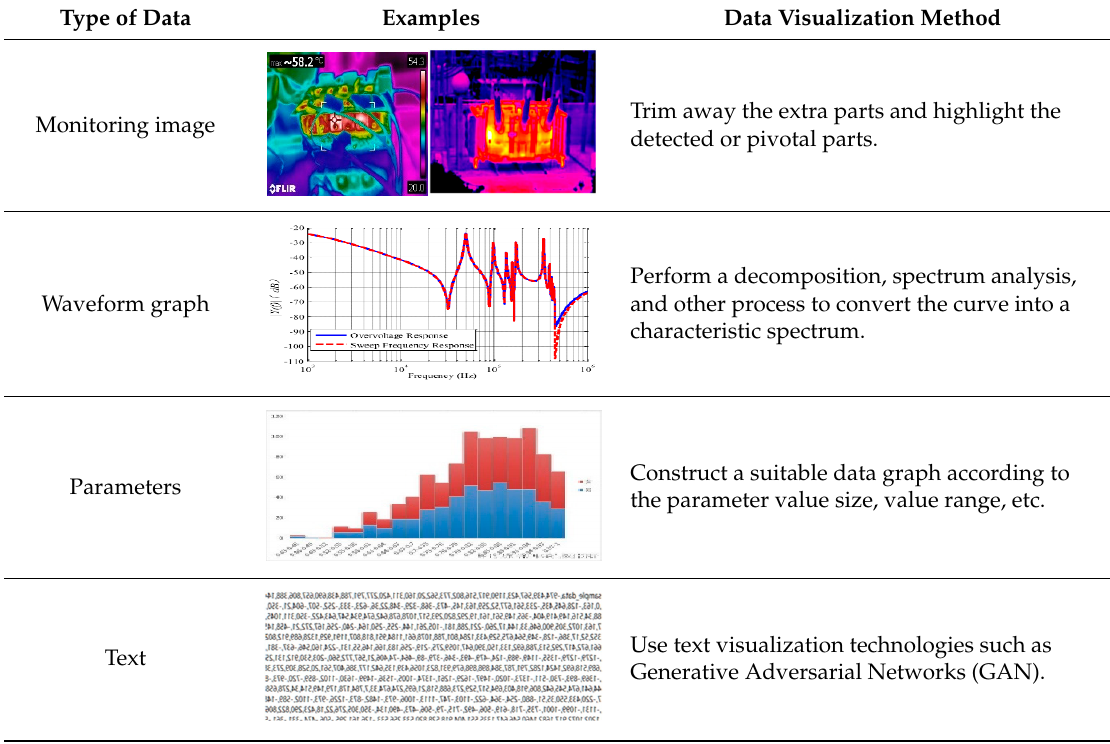
Table 2. Data visualization methods.